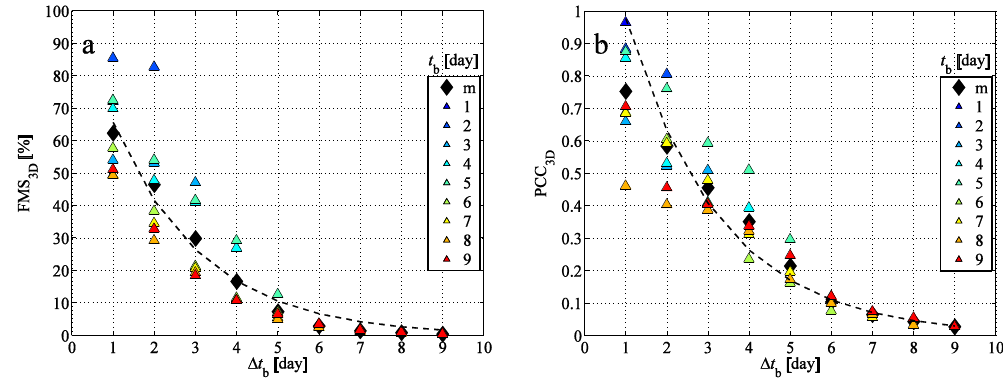
Figure 6. ( a ) The figure of merit in space FMS 3D between the BWCs and FWC depending on the time period ∆ t b of the backward simulation; ( b ) Pearson’s correlation coefficient PCC 3D between the BWCs and FWC. Colored triangles indicate the starting time t b of the backward simulations (see the color legend); black diamonds (in some cases in overlap with triangles) are the mean values belonging to a given ∆ t b (denoted by “m”). Dashed lines indicate exponential fits to mean values; the exponents are given in Table